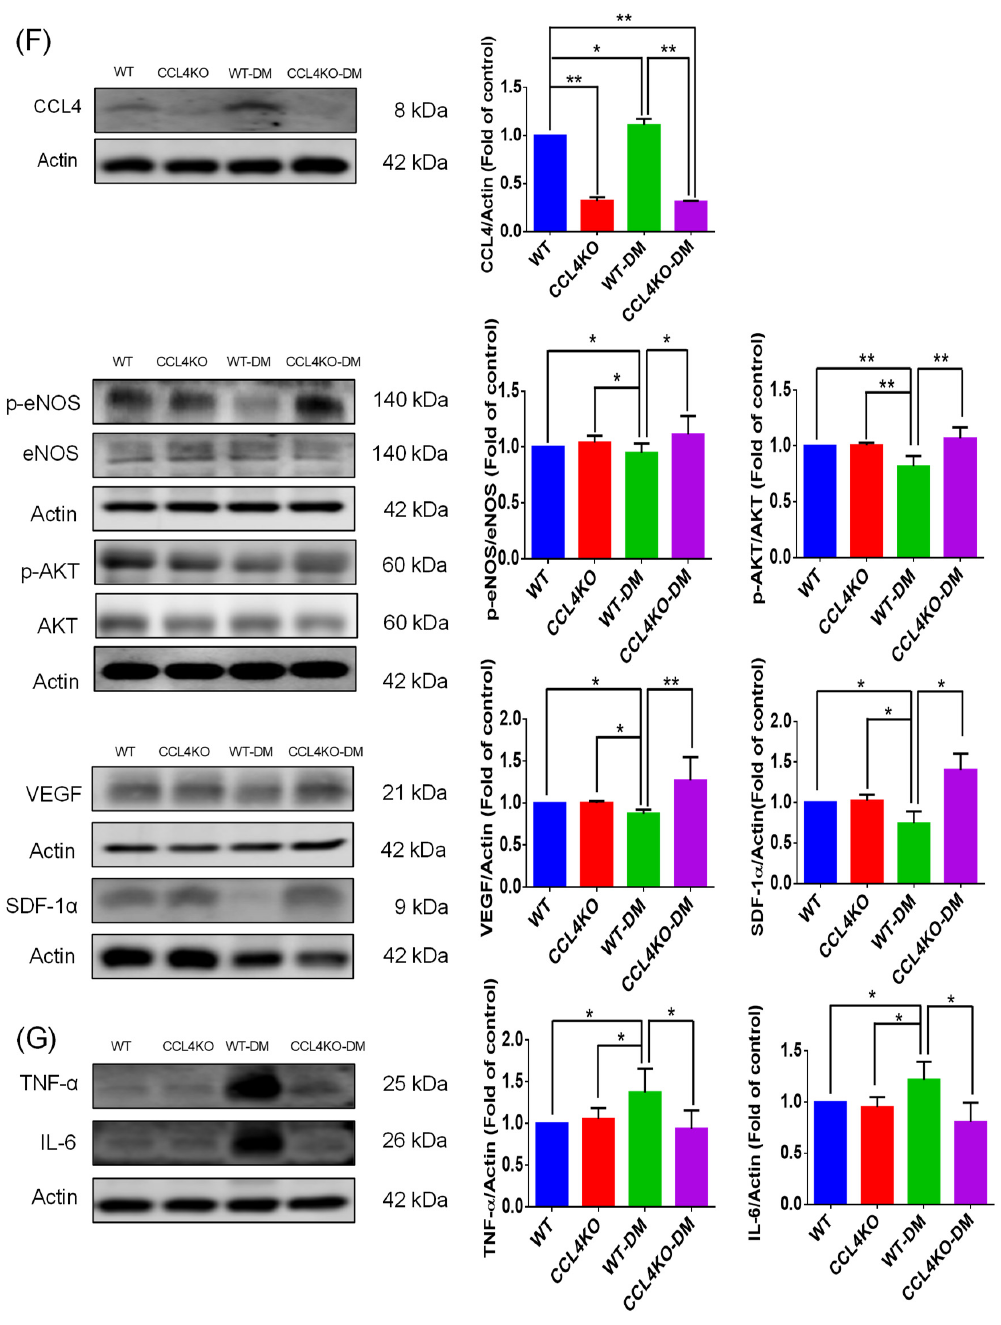
Figure 3. CCL4 inhibition by knockout improved wound repair in diabetic mice. Representative wound areas ( A ). The closure rates of 3-millimeter punch biopsies were measured (( B ); n = 6). Representative images with H&E staining ( C ). Representative images with immunostaining of CD31 and Ki67. Both CD31- and Ki67-positive areas were enhanced in the CCL4-knockout mice ( D , E ). Western blotting and statistical analyses of CCL4, p-AKT, p-eNOS, VEGF, and SDF-1 α in the wound area. The angiogenic proteins were enhanced in tissues from the CCL4-knockout mice (( F ); n = 3). Western blotting and statistical analyses of TNF- α and IL-6 in the wound area. The inflammatory proteins were decreased in tissues from the CCL4-knockout mice (( G ); n = 3). WT, wild-type mice; CCL4KO, CCL4-knockout mice; WT-DM, wild-type diabetic mice; CCL4KO-DM, CCL4-knockout diabetic mice. * p < 0.05, ** p < 0.01 compared with WT, # p < 0.05 compared with WT-DM.